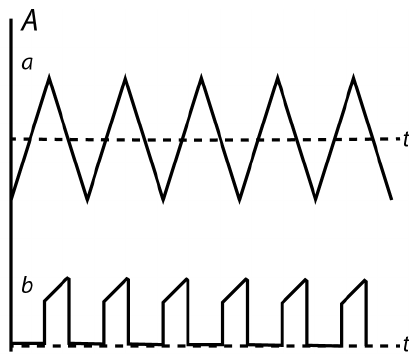
Figure 2. Some possible types of the waveform.